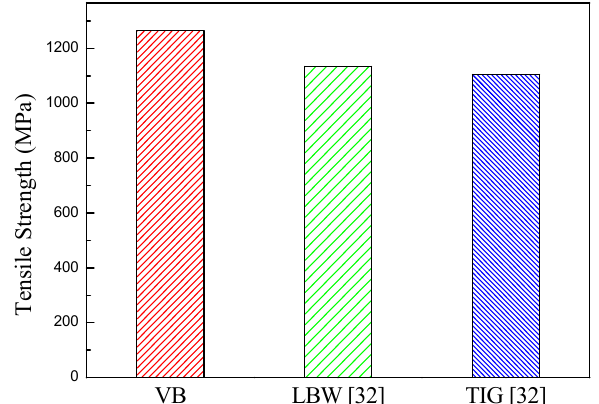
Figure 10. Comparison of Tensile Strength of VB, TIG, and LBW.